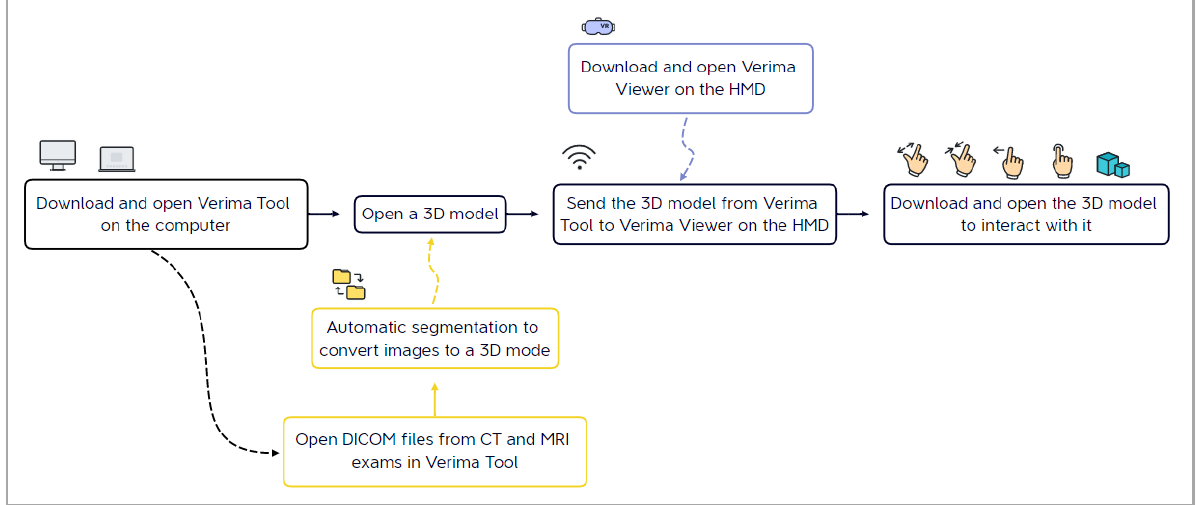
Figure 3. The main steps for the visualization of a surgical case on an HMD, starting from the elaboration of radiological images.